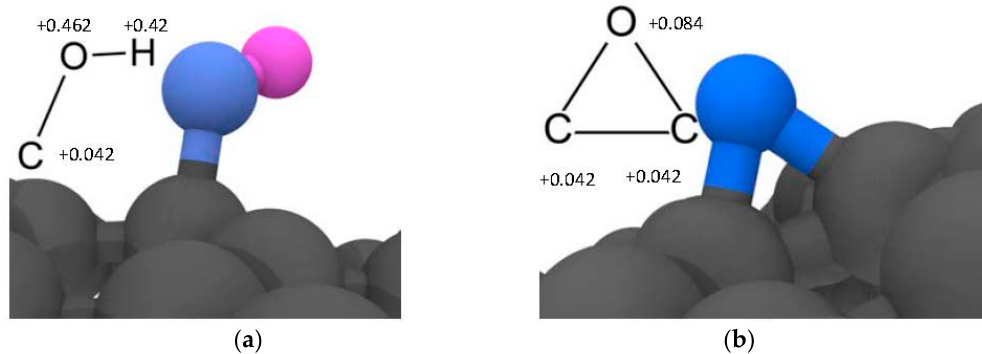
Figure 3. Types of functionalization introduced on the graphene surface: ( a ) hydroxyl group (C-OH) and ( b ) oxirane group (C-O-C). The bonds and the angles interactions between the functional groups and the carbon atoms of the filler were chosen according to the COMPASS force field and the nonbond interactions between the functional groups and polymer molecules.